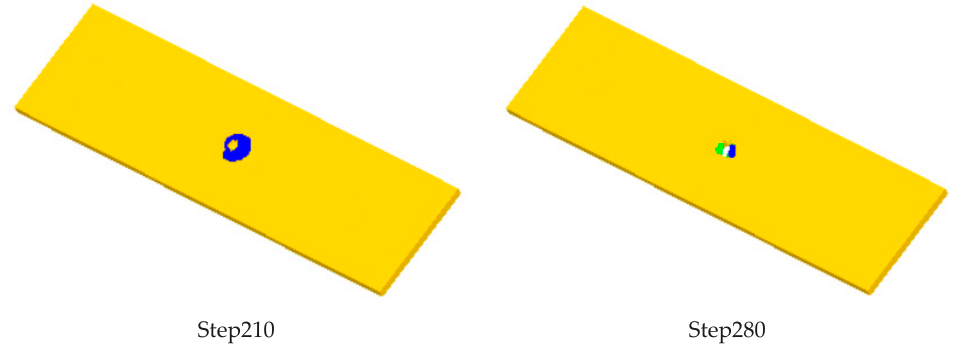
Figure 8. Stress effect of billet in different simulation steps.